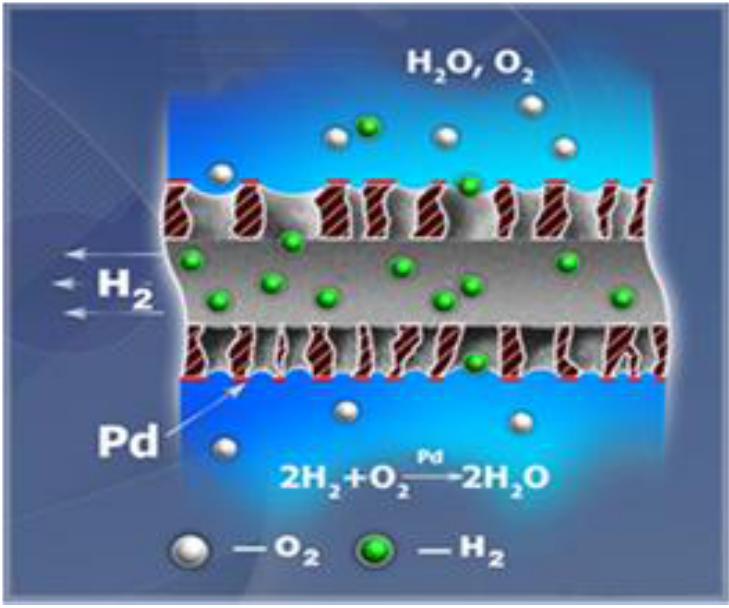
Figure 8. The principle of dissolved oxygen removal in catalytic gas-liquid hollow fiber membrane contactor (adapted from [92]).